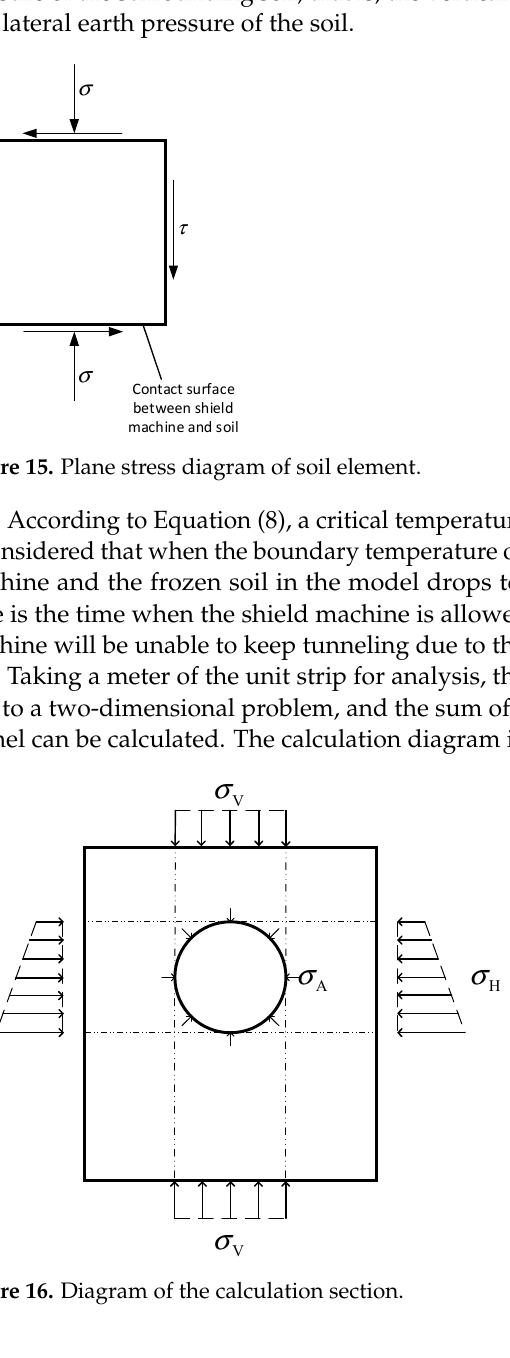
Figure 16. Diagram of the calculation section.